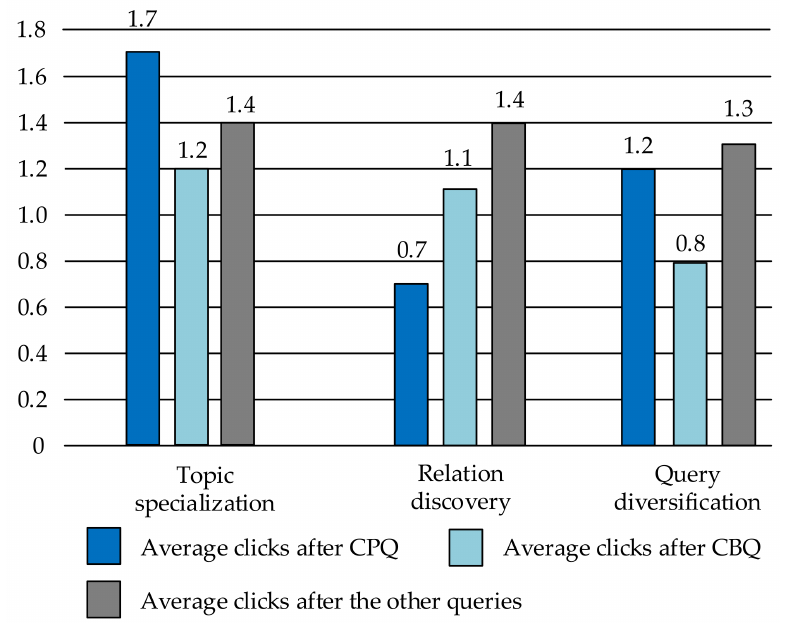
Figure 7. Distribution of three aspects of the average number of clicks in QCB sessions for each QCB